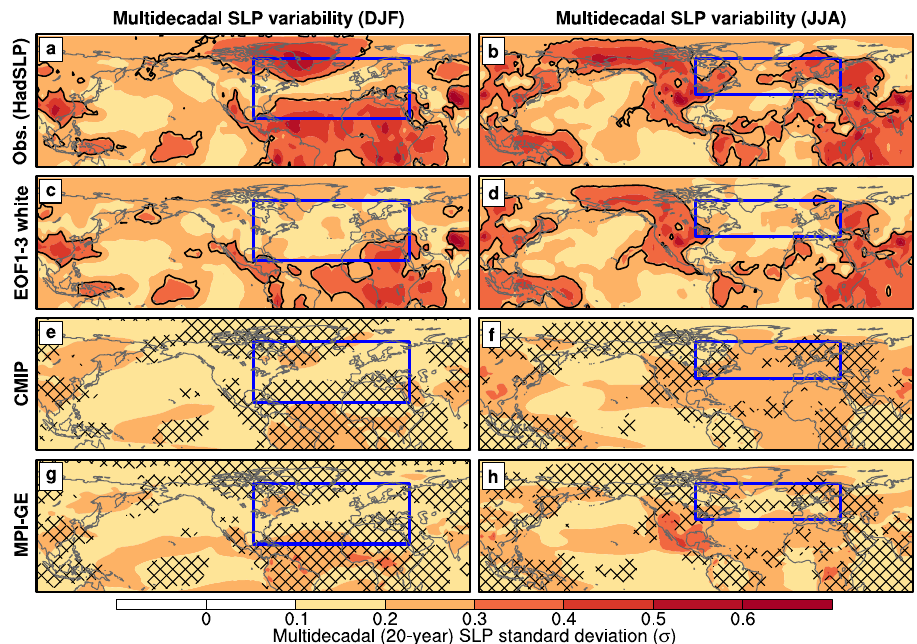
Fig. 1 Multidecadal large-scale circulation variability in observations and models. a The multidecadal variability of winter (DJF) sea-level pressure in the HadSLP2 observational data set over the period 1901 – 2005, where the SLP variability has been normalised by the interannual variability at each grid point. The multidecadal component is calculated using 20-year running mean. c The average multidecadal variability of winter sea-level pressure in a synthetic data set in which the fi rst three EOFs of interannual SLP variability over the North Atlantic sector in the HadSLP2 data set are replaced with random white- noise timeseries (the average of 10,000 random realisations is shown). e The ensemble mean of the multidecadal large-scale circulation variability in CMIP model realisations (from both CMIP5 and CMIP6) over the period 1901 – 2005 (the multidecadal SLP variability was calculated in each model realisation individually, prior to taking the ensemble mean). g As in e but for the 99-member MPI-GE simulations over the period 1901 – 2005. b , d , f , h are as in a , c , e , g , respectively, but for the boreal summer season (JJA). The black contours in a – d show where the multidecadal variability is signi fi cantly different from that expected from a white-noise process (at the 95% level, estimated using a Monte Carlo test with 10,000 realisations). The black hatching in e – h show where the multidecadal variance in the HadSLP2 observations for the respective seasons exceeds the 95th percentile of each of the ensemble distributions. The blue boxes show the regions used to calculate the SLP EOF